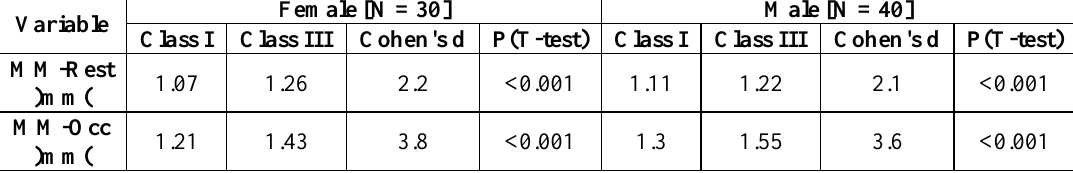
Male [N = 40] Female [N = 30]